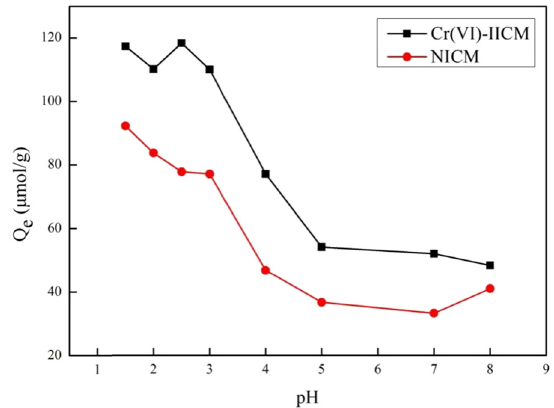
Figure 7: E ff ect of pH on adsorption.